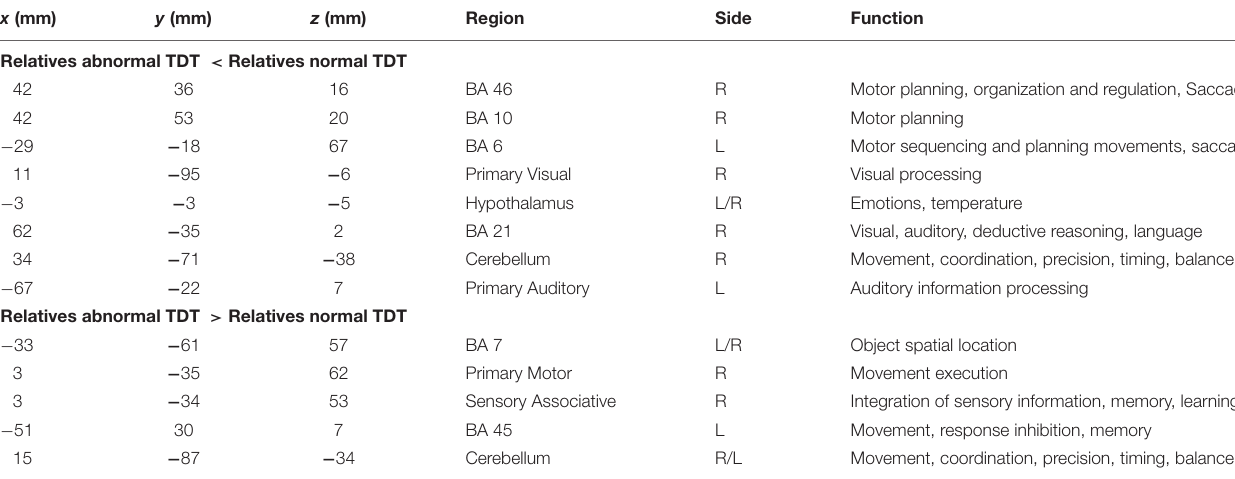
TABLE 3 | Significant differences in ALFF differences (corrected p < 0.05) between relatives with normal and abnormal TDT.